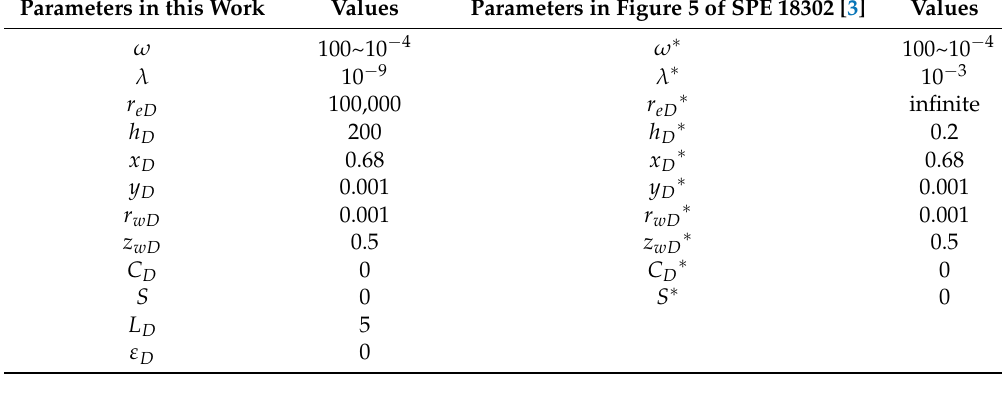
Table 2. Basic data used for verification of the model.